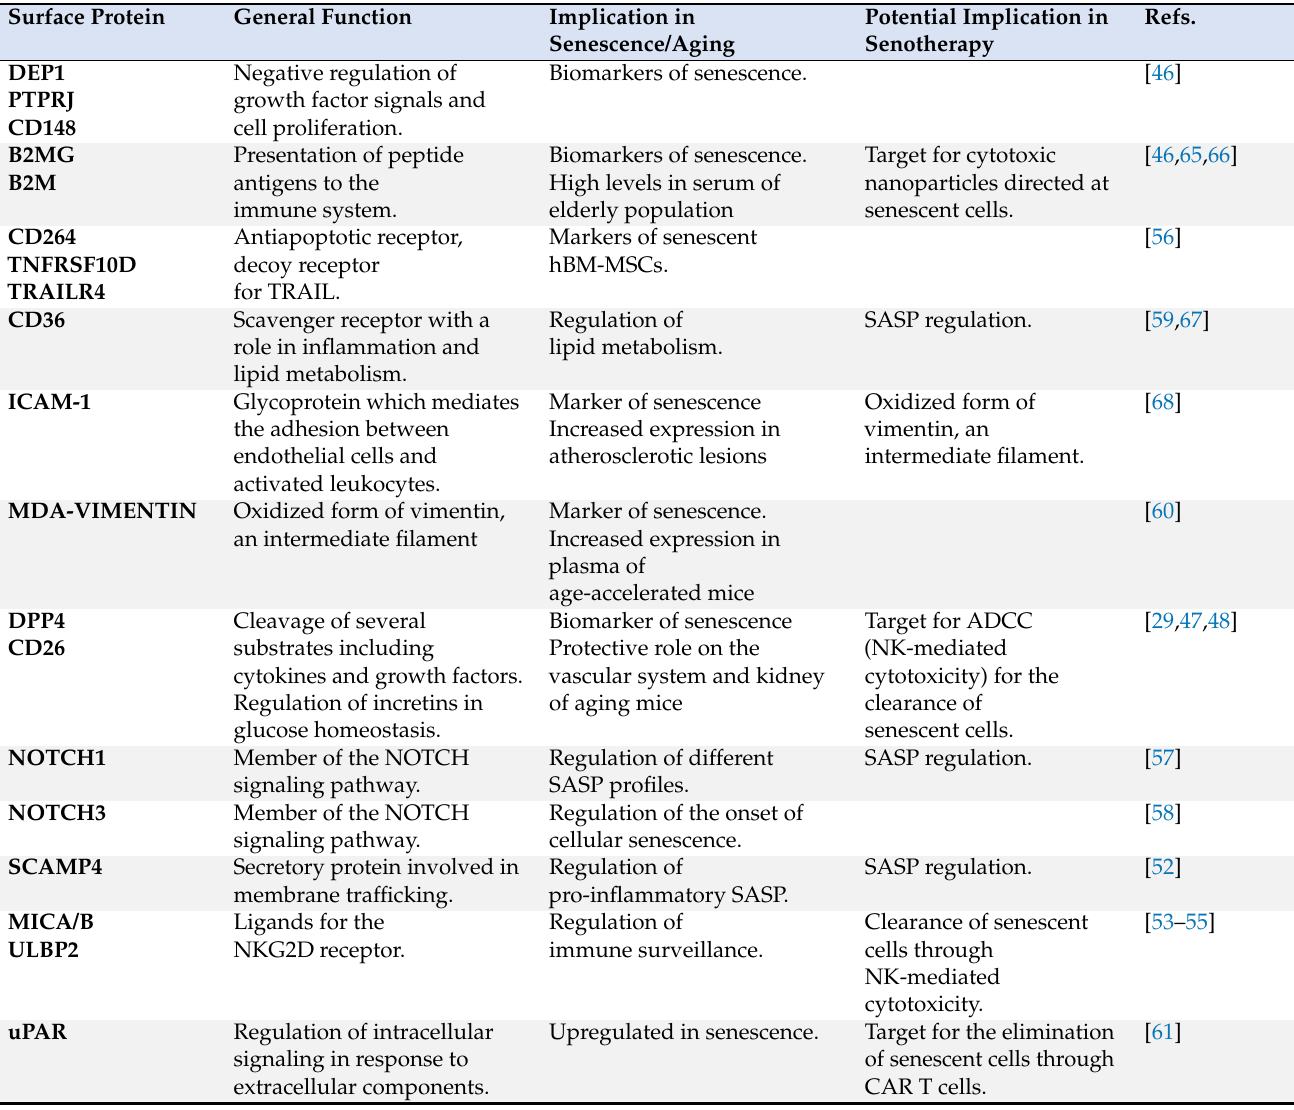
Table 1. Surface molecules as senescence biomarkers implicated in